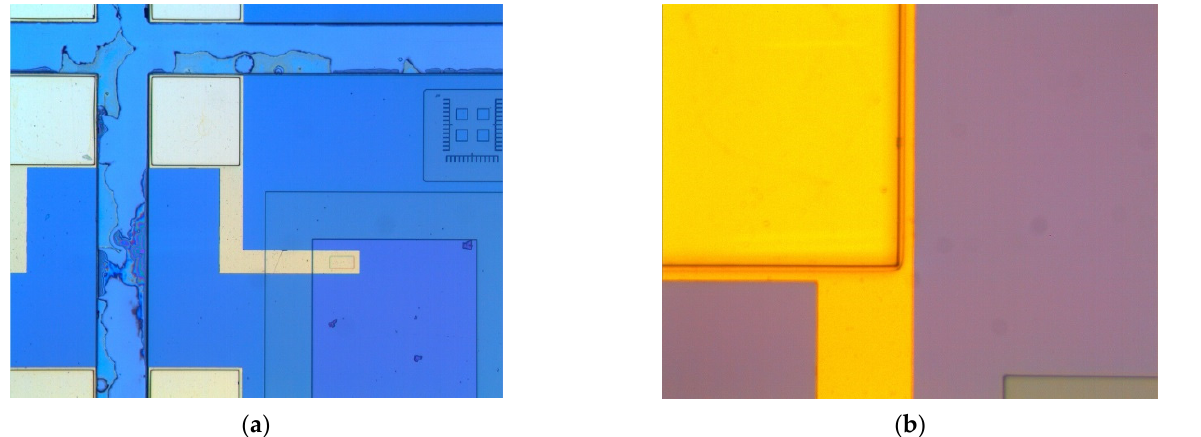
Figure 5. ( a ) Optical view of one external pad plus metallic trace to the source contact plus alignment sign and ( b ) details of the gold pad and gold trace to the source.